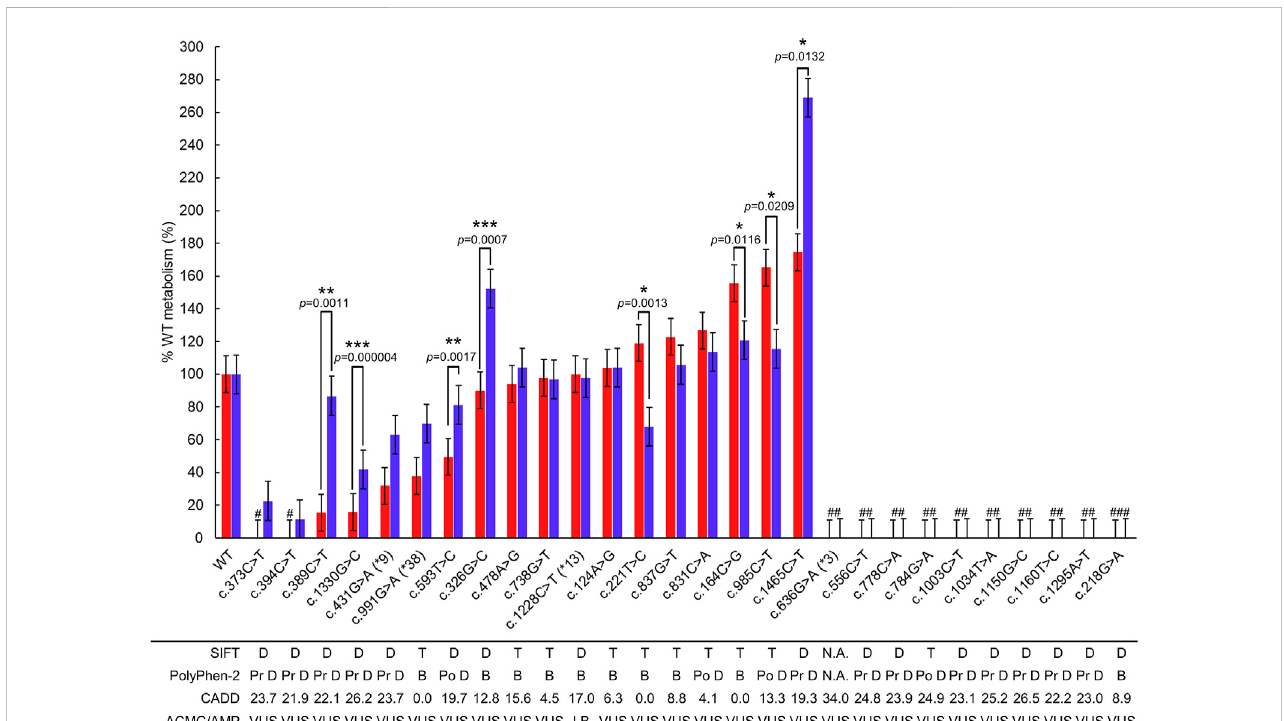
FIGURE 3 Metabolizing capability compared to WT P450 2C19 metabolism of mephenytoin and omeprazole. The metabolic capability of each polymorphic P450 2C19 was compared with WT using OH-mephenytoin (red bar) or 5-hydroxy omeprazole (blue bar) formation. Each bar represents %WT ± SE of the polymorphic P4502C19containingthevariant. VariantswithSIFTscorelessthan.05arepredictedtobedeleterious(D),thosegreaterthanorequal to.05are predicted to be tolerated (T) as described in SIFT algorithm. If the PolyPhen-2 score is between the following intervals (0, .2), (.2, .85), and (.85, 1), the scores are predicted to be benign (B), possibly damaging (Po D) and probably damaging (Pr D), respectively, as described in the algorithm. For the variants indicatedsigni fi cantlydifferentmetabolizingcapabilitybetweenthetwosubstrates, p -values < .05, p -values < .01,and p -values < .001aremarkedas*,**,and ***, respectively. # The formation of metabolites was not detectable. ## The expression of polymorphic CYP2C19 containing the variant was not detectable in the immunoblotting. ### The spectral peaks at approximately 450 nm were not readily detected in the microsome extracts. LB, Likely Benign; VUS, Variant of Uncertain Signi fi